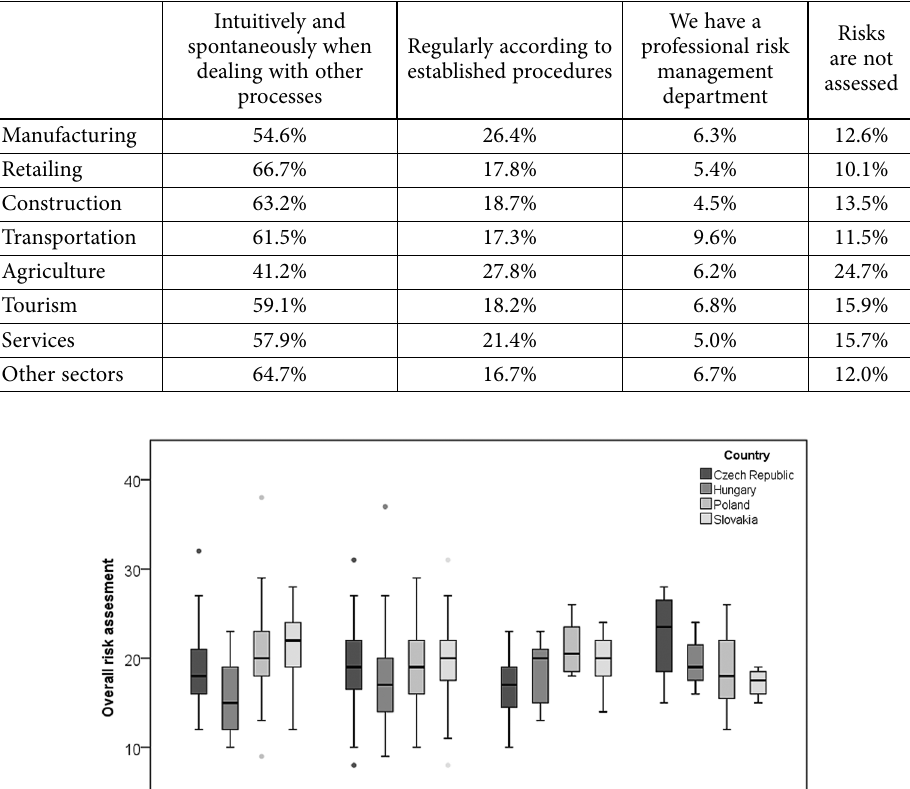
Table 1. Identification and quantification of risks in companies by sector (source: own research)